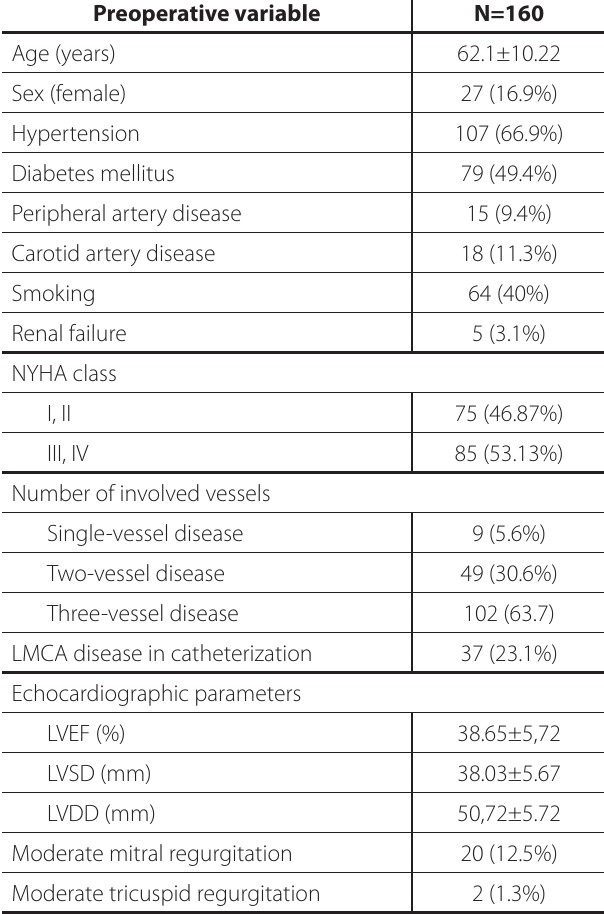
Table 1 . Demographic characteristics.